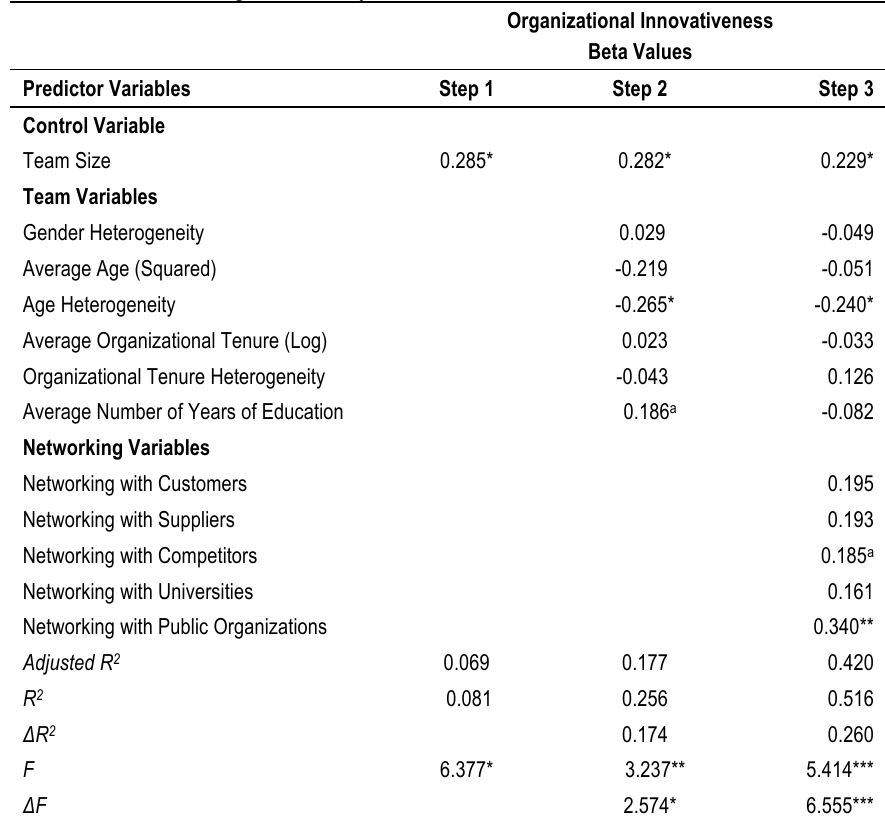
Table 3. Hierarchical Regression